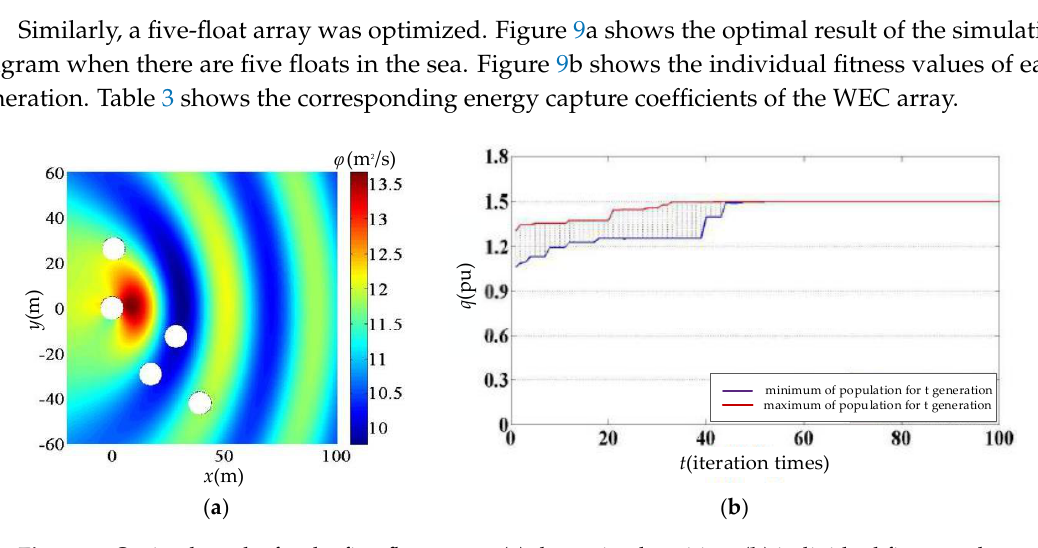
Figure 9. Optimal results for the five-float array: ( a ) the optimal position; ( b ) individual fitness values for each generation. Table 3. Energy capture coefficient of the WEC array ( N = 5).